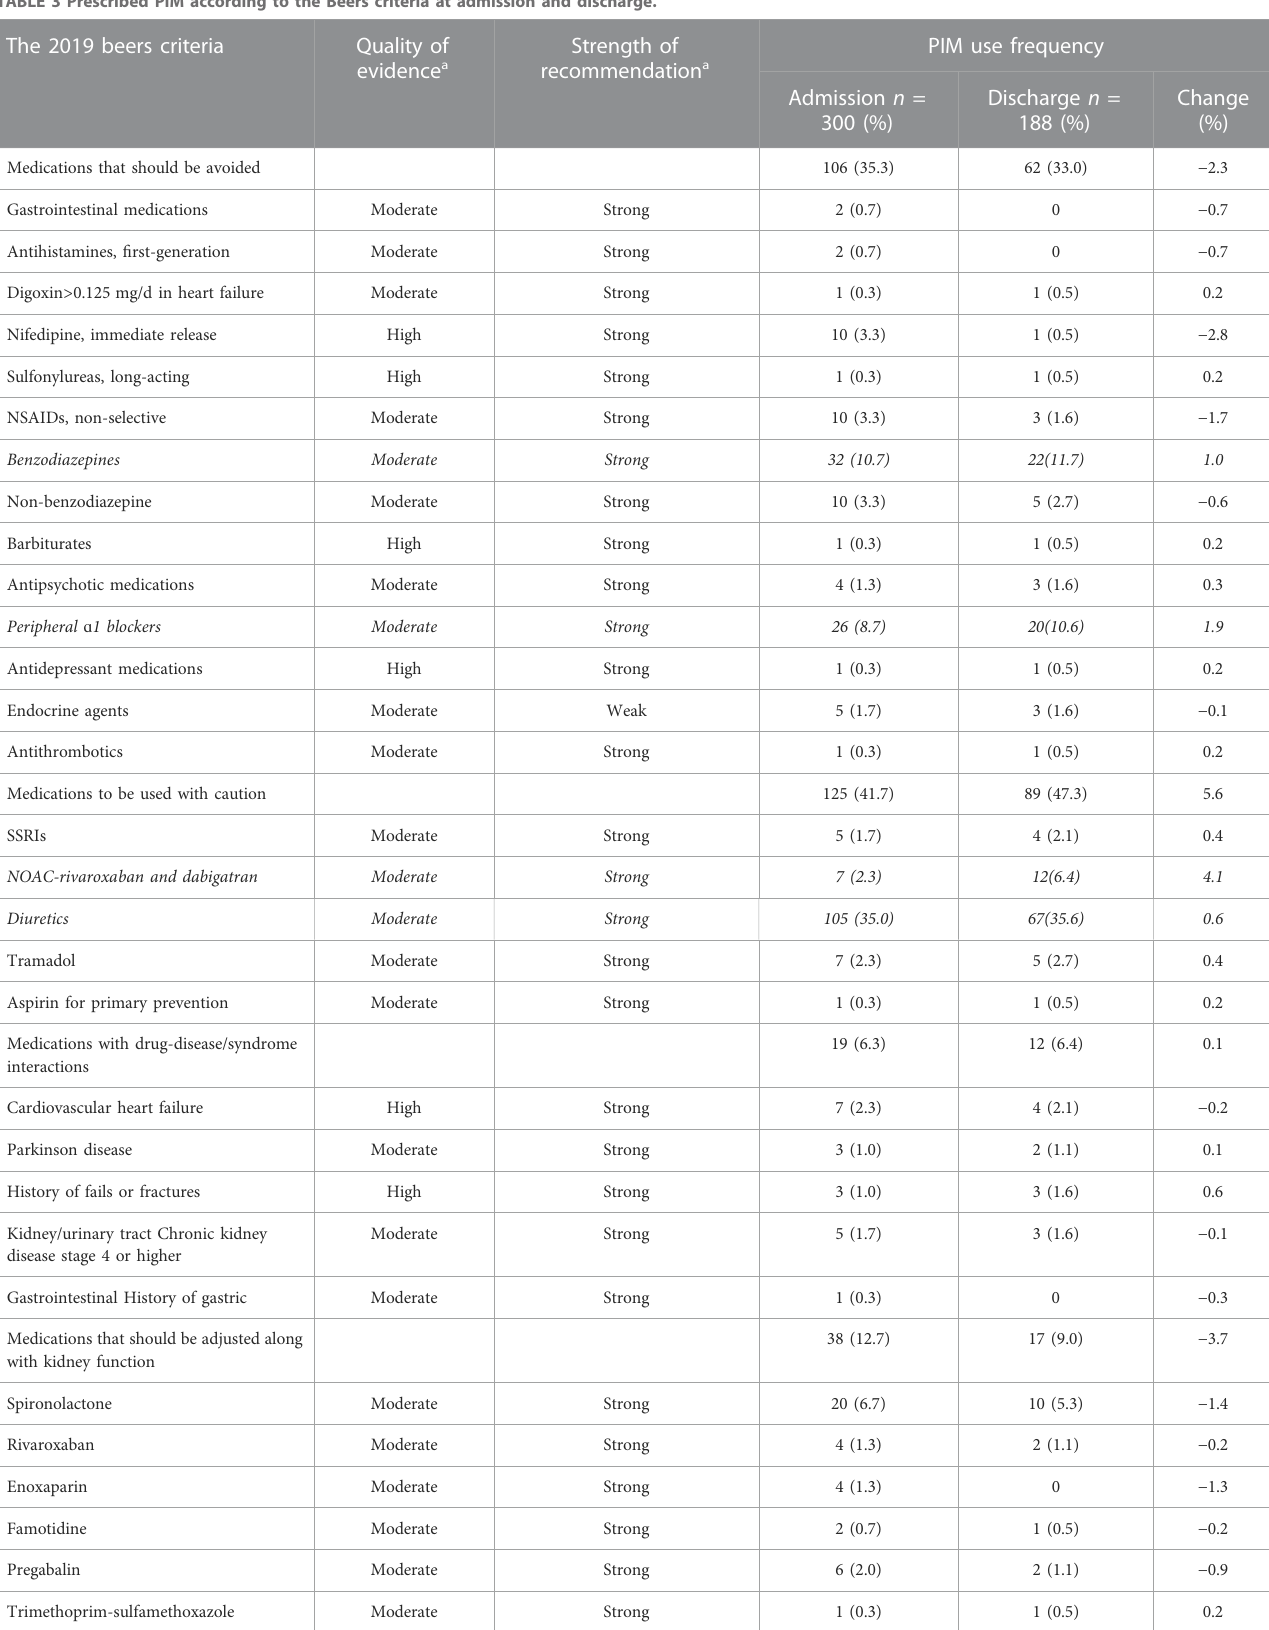
TABLE 3 Prescribed PIM according to the Beers criteria at admission and